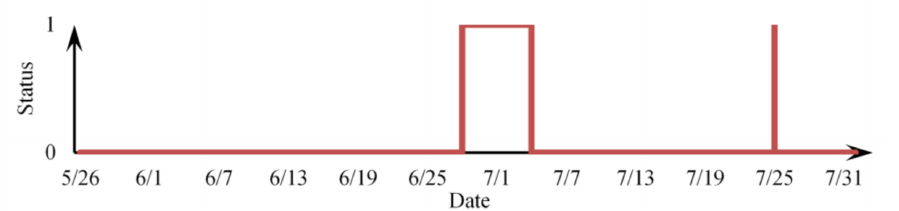
Figure 5. Water pumping station operation status.